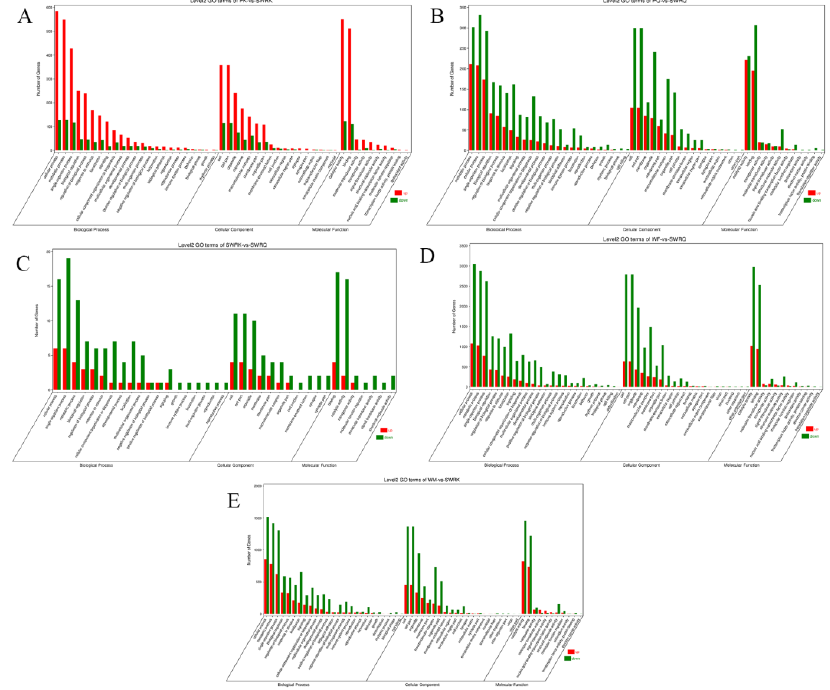
Figure 2. Histogram presentation of the Gene Ontology (GO) classification in each caste. ( A ) PK-vs-SWRK; ( B ) PQ-vs-SWRQ; ( C ) SWRK-vs-SWRQ; ( D ) WF-vs-SWRQ; ( E ) WM-vs-SWRK. PKs (primary king), PQs (primary queen), SWRK (secondary worker reproductive king), SWRQ (secondary worker reproductive queen), WMs (workers male), and WFs (female workers). The figure represents the up (red) and down (green) categorical presentation of biological processes, cellular components, and molecular functions. The x-axis indicates the names of genes in a category, and the y-axis shows the number of genes in the main category.